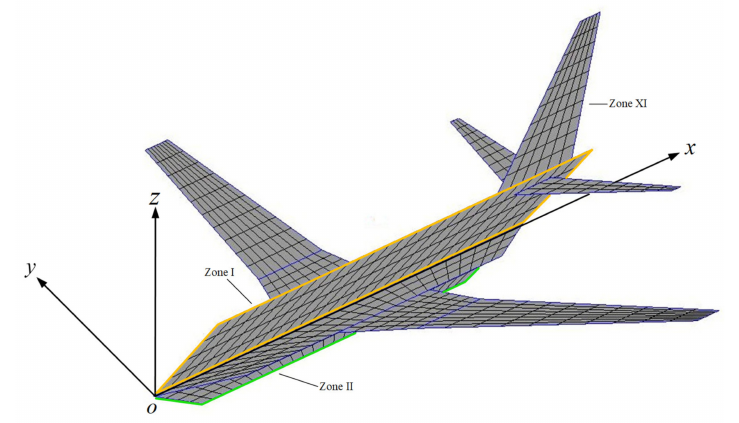
Figure A1. The cruciform assembly of the